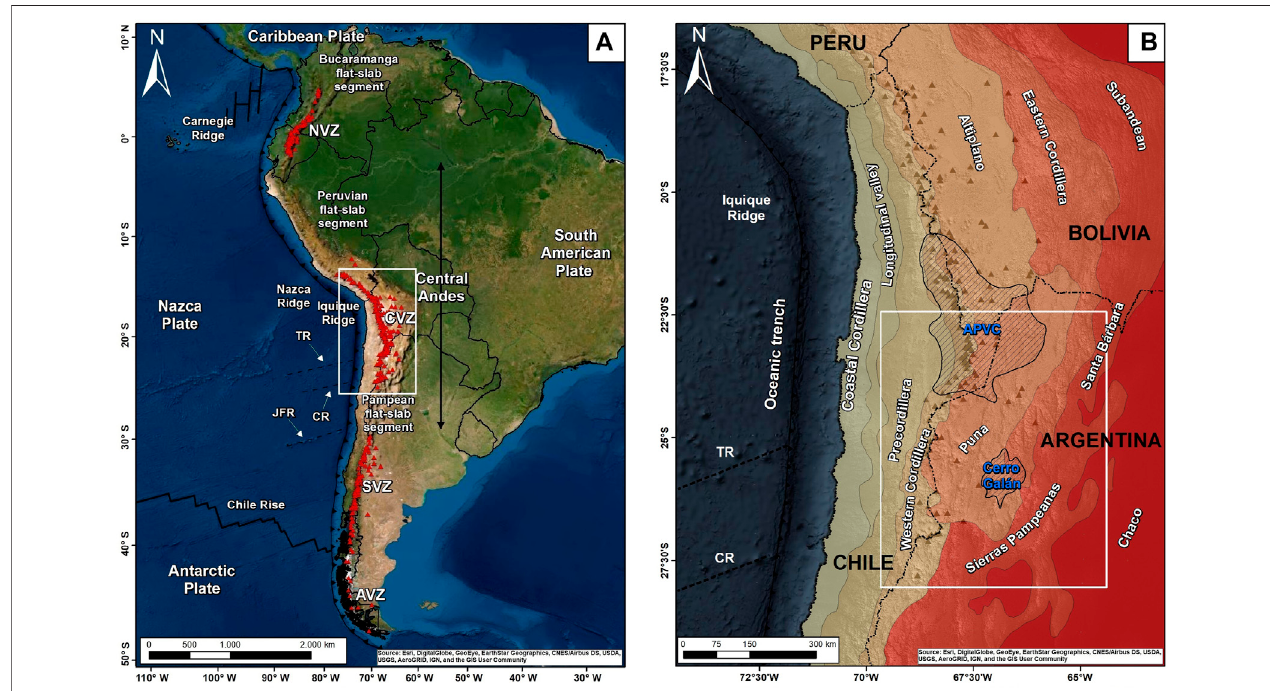
FIGURE 1 | (A) Location map of the Central Andes, showing the main tectonic elements. JFR = Juan Fernández, TR = Taltal, and CR = Copiapó ridges. NVZ = Northern Volcanic Zone, CVZ = Central Volcanic Zone, SVZ = Southern Volcanic Zone, and AVZ = Austral Volcanic Zone, according to Stern et al. (2007). (B) Main tectonomorphic regions of the Central Andes. White rectangle in (B) indicates our study area. Red triangles in (A) and grey triangles in (B) correspond to the Neogene- QuaternaryvolcanoesaccordingtoSiebertetal.(2010).Theblackstripedregionsin (B) showtheAltiplano-PunaVolcanicComplex(APVC;deSilva,1989)andthe Cerro Galán (Kay et al., 2011) ignimbrite